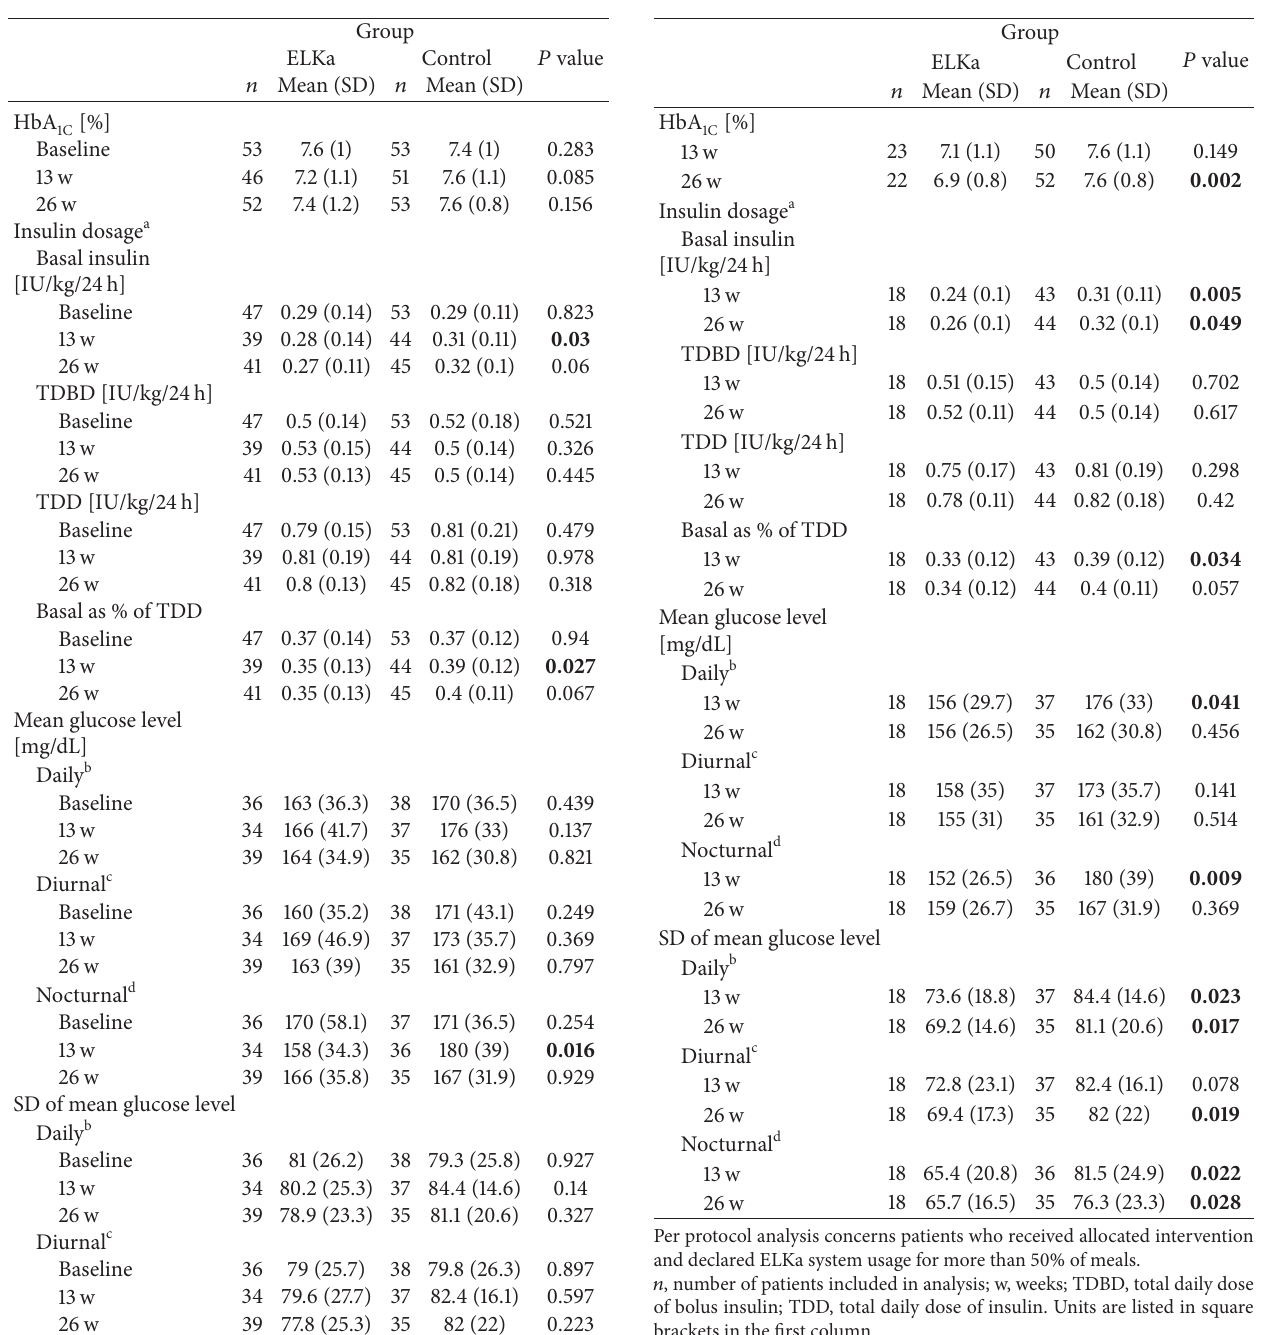
Table 2: Summary results of the intention-to-treat analysis. Table 3: Summary results of the per protocol analysis.